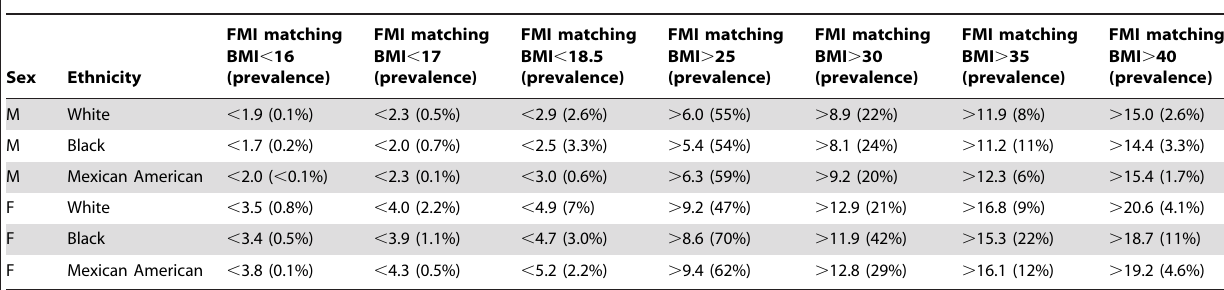
Table 3. FMI (kg/m 2 ) thresholds with the same prevalence as a given BMI threshold at age 25.